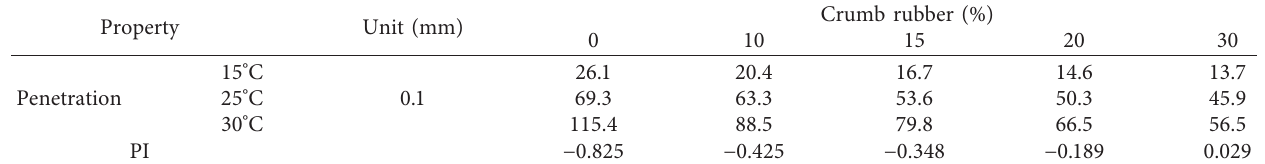
Table 3: Test results of crumb rubber-modified